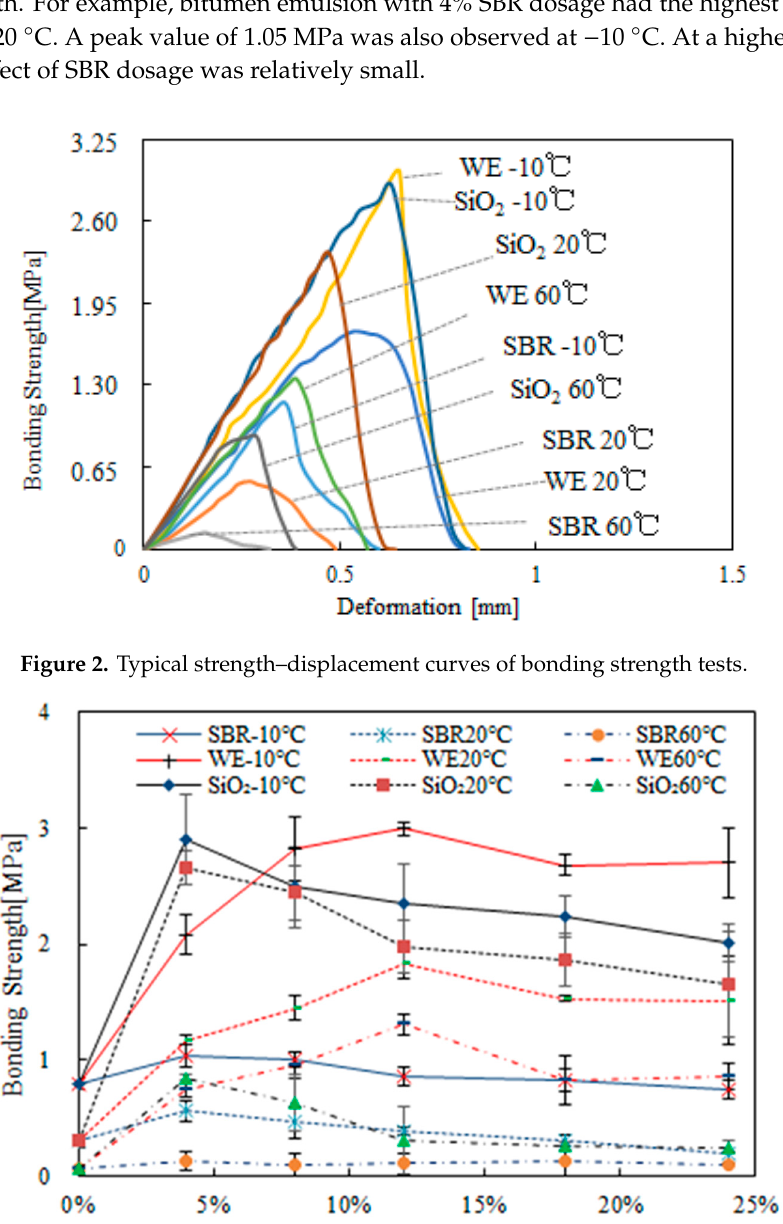
Figure 3. Effect of modifier dosage and temperature on bonding strength of various types of modified bitumen emulsion.